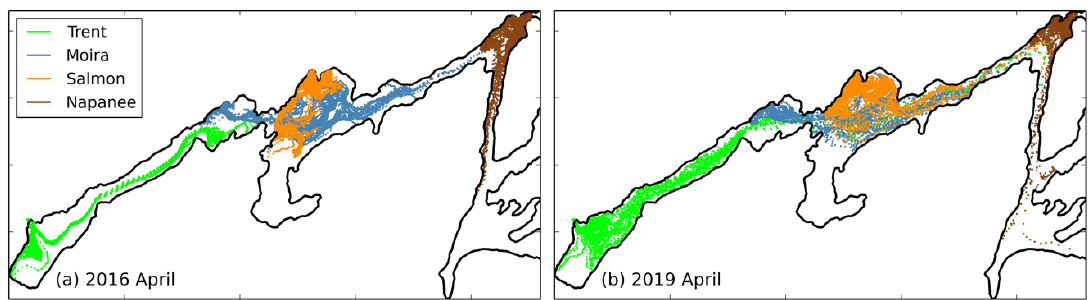
Figure 10. Particle paths originating from the four rivers on 1 April ( a ) 2016 and ( b ) 2019. Particles had a settling speed of 0.113 m/day and were tracked for 30 days or until they reached the bottom.